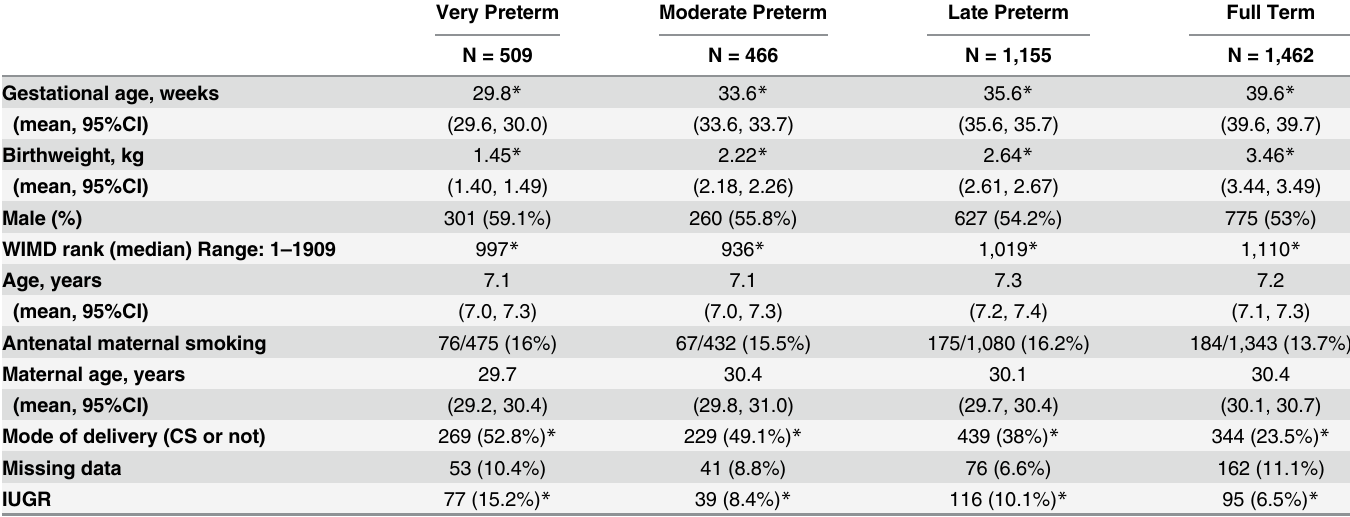
inhaler treatment for both age ’ s groups (Table 5). Table 2. Characteristics of responders ’ ≥ 5 years of age according to gestational